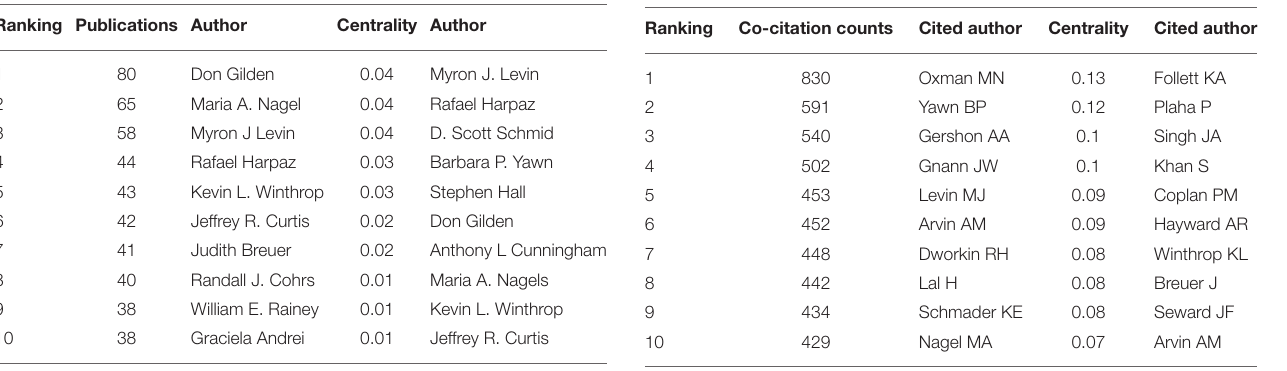
TABLE 3 | Top 10 active authors in terms of publications and centrality for herpes zoster.